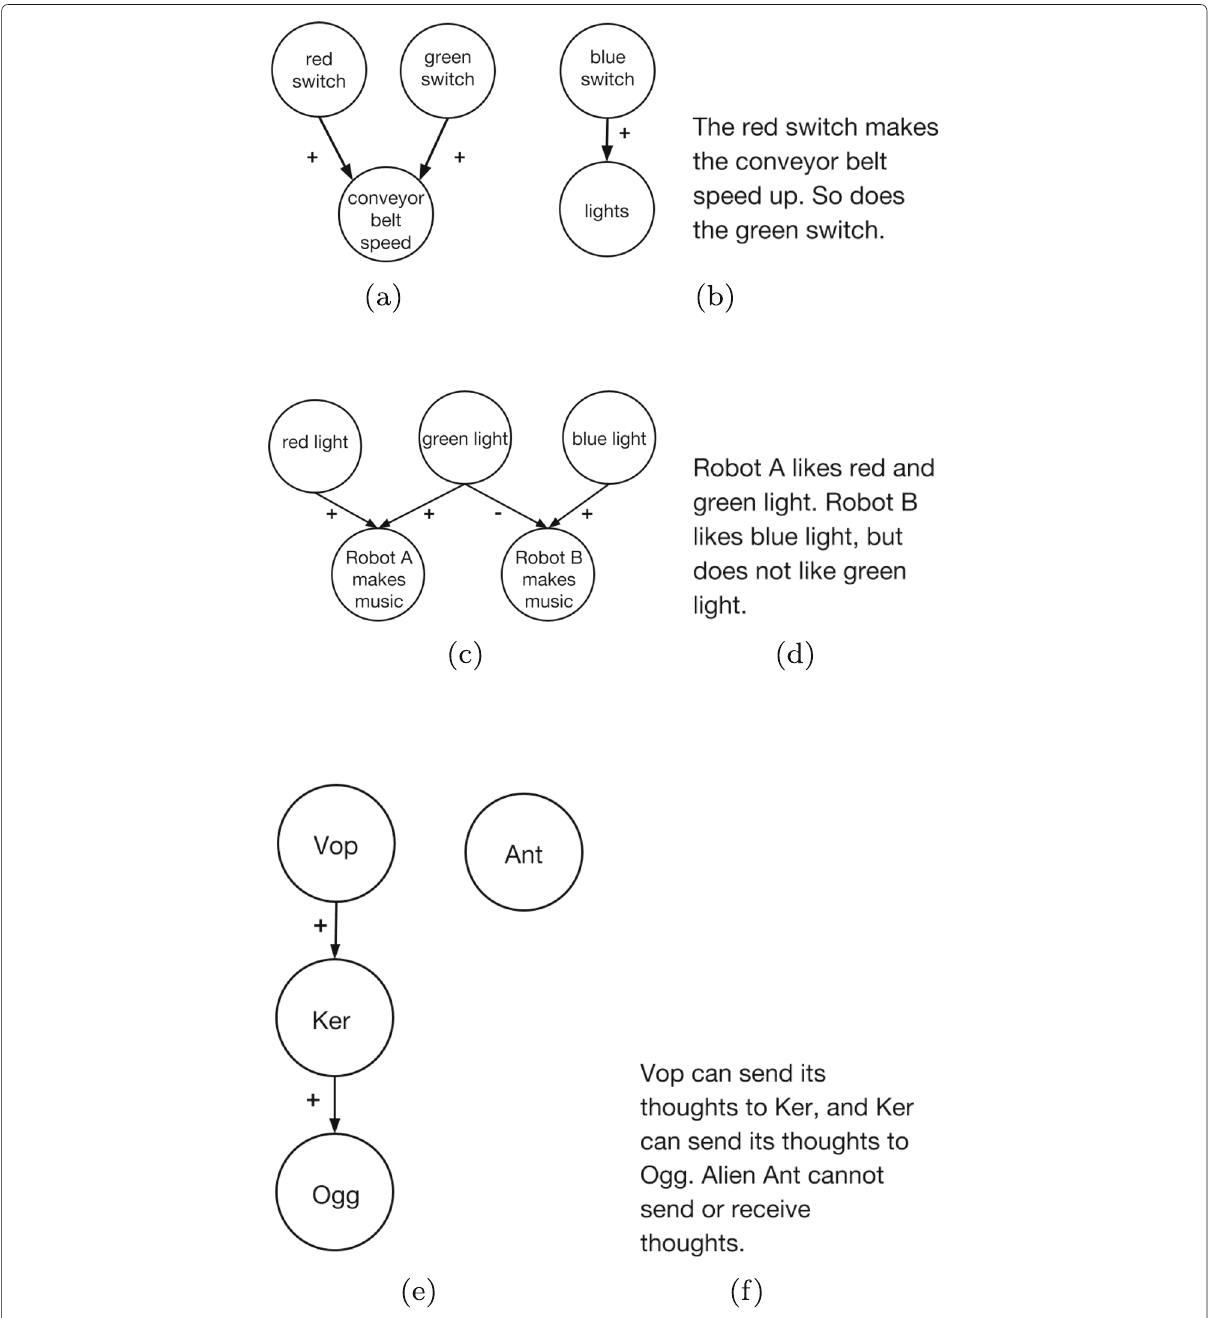
Fig. 6 Causal information for control questions in Experiment 4. a Common effect diagram. b Common effect text. c Common effect and common cause diagram. d Common effect and common cause text. e Causal chain diagram. f Causal chain text and next the three control questions (in random order).